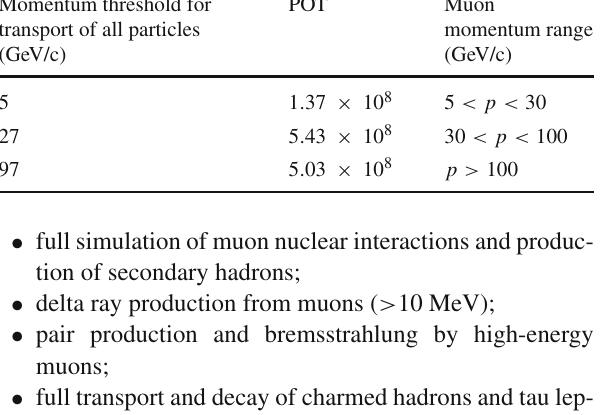
Table 3 FLUKA samples produced for Muon Flux comparison with GEANT4 Momentum threshold for transport of all particles